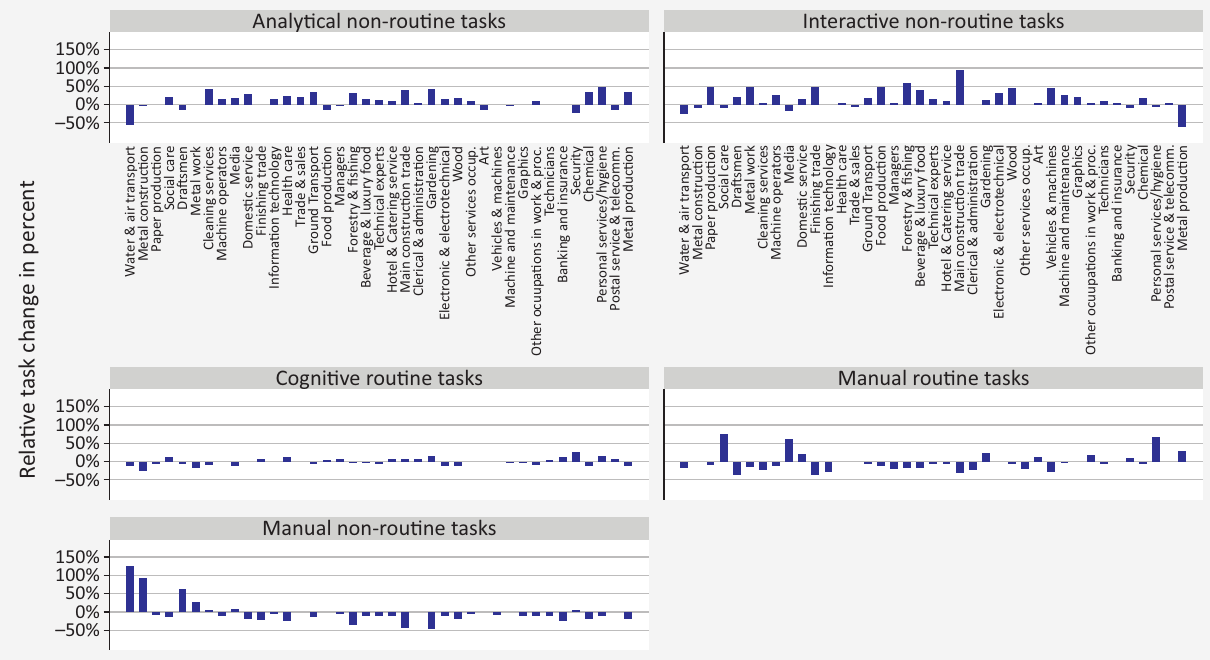
Figure 4. Relative change of task shares after professional education by occupational field, sorted from left to right by return size.